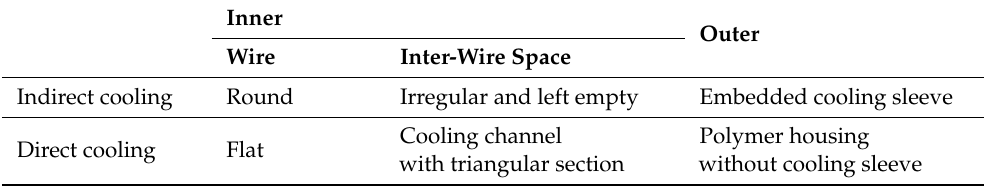
Table 6. Cooling techniques for copper winding inside electric motors (injection moulding).